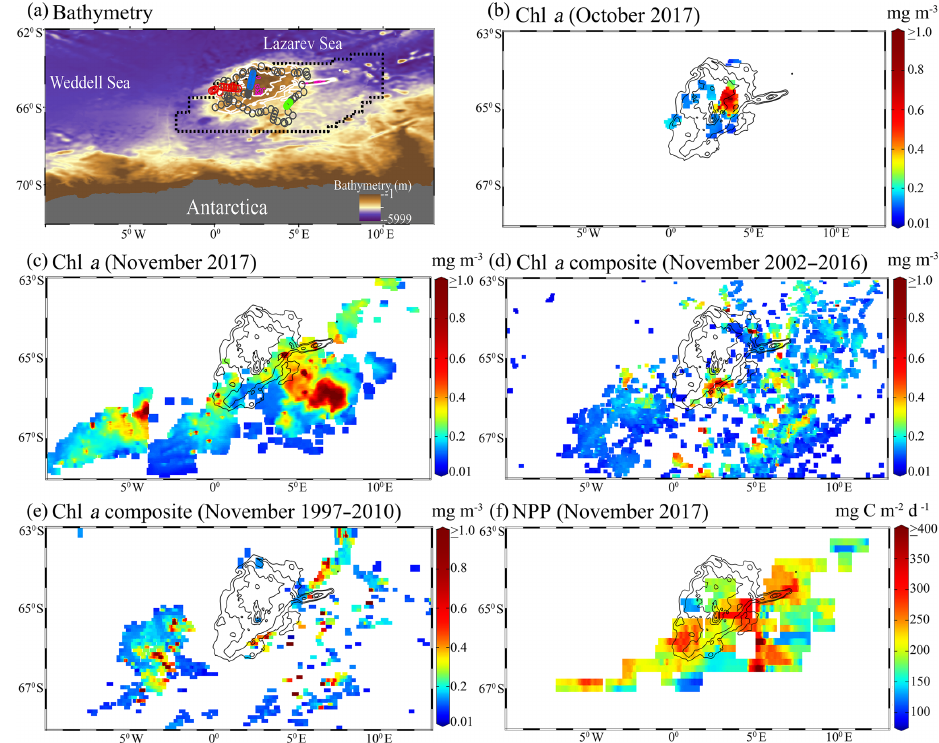
Figure 1. (a) Bathymetry map of the Maud Rise from the Earth Topography One Arc-Minute Global Relief Model, 2009. Pink lines show the depth contours shallower than 2000m, and other white contours are spaced by 500m with deeper values. The dashed polygon shows the extent of the polynya on 21 November 2017. Circles represents the location of an ARGO float (ID-5904468) from 19 January 2015 to 18 March 2018. Red, green, and blue circles show the float location from August to December for 2017, 2016, and 2015, respectively. (b) Monthly mean chlorophyll a (chl a) from the Aqua Moderate Resolution Imaging Spectroradiometer (Aqua MODIS) during Octo- ber 2017. (c) Monthly mean chl a from Aqua MODIS during November 2017. (d) Long-term composite of Aqua MODIS chl a (2002–2016) for November. (e) Long-term composite of SeaWiFS chl a (1997–2010) for November. (f) Monthly mean daily net primary productivity (NPP) computed from the Eppley vertically generalized production model for November 2017. The polyline features in (b–f) show the extent of the Maud Rise seamount with a contour interval of